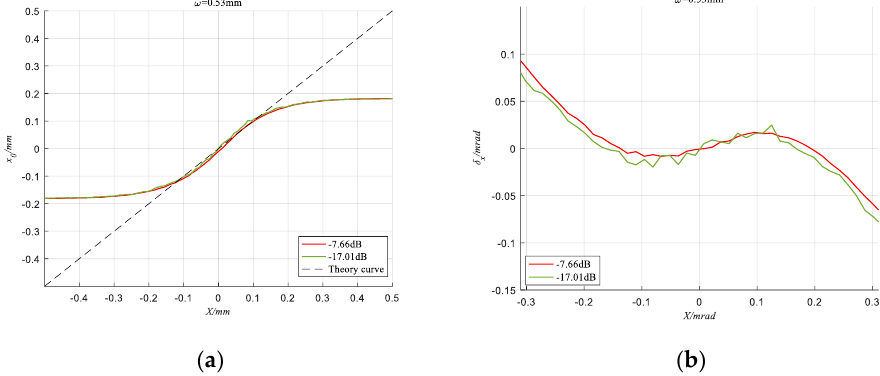
Figure 11. When ω = 0.53 mm, detection results of TRC method under different SNR conditions. ( a ) The Calculated coordinate curve; ( b ) Absolute error.